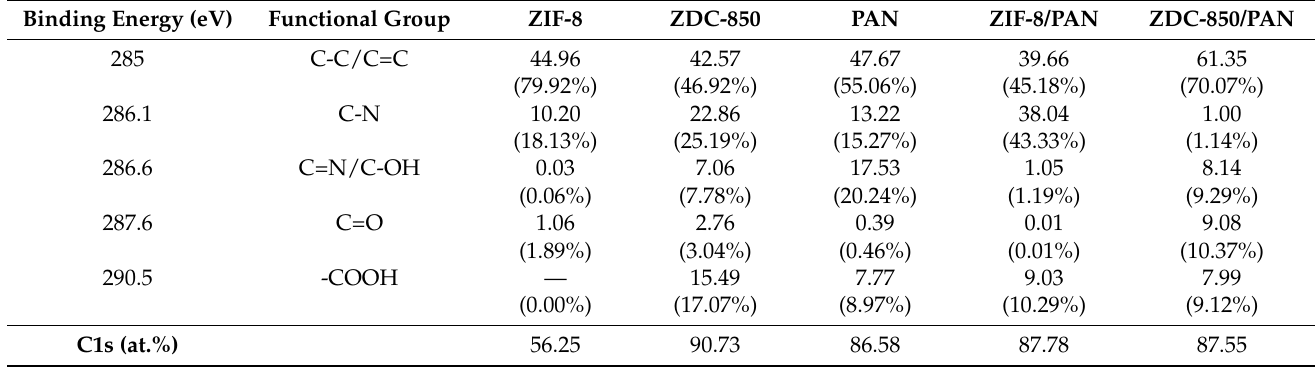
Table 4. Results of the fit of the XPS C 1s region; values given in at% (percentage of total